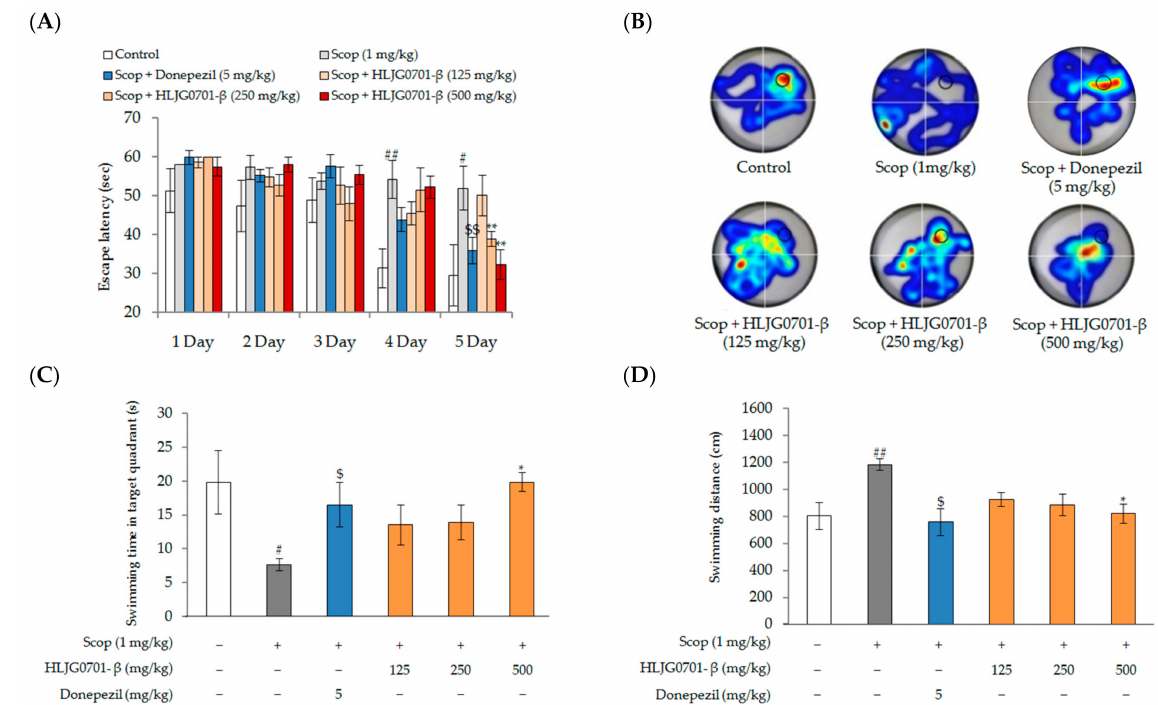
Figure 5. The Morris Water Maze task in scopolamine-induced male mice. ( A ) escape latency; ( B ) heatmap images; ( C ) swimming time in target quadrant; ( D ) swimming distance. Data are presented as mean ± standard deviation. Error bar: standard deviation. ##, significant difference compared with control by Student’s t -test, p < 0.01; #,significant difference compared with control by Student’s t -test, p < 0.05; $$,significant difference compared with scopolamine group by Student’s t -test, p < 0.01; $, significant difference compared with scopolamine group by Student’s t -test, p < 0.01; **,significant difference compared with scopolamine group by one-way ANOVA, p < 0.01; *,significant difference compared with scopolamine group by one-way ANOVA, p <